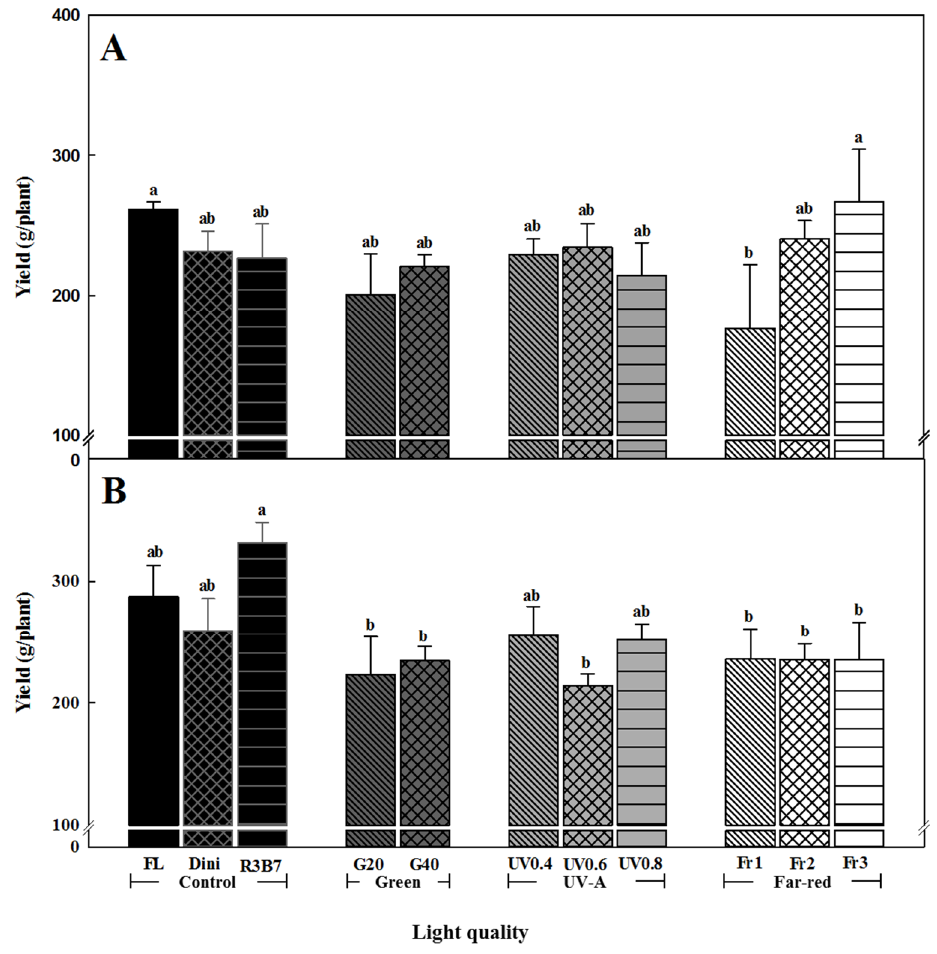
Figure 11. The effects of light quality on yield of first flower cluster ( A ) and yield of second flower cluster ( B ) of ‘Mini Chal’ tomato ( Solanum lycopersicum L.) measured after transplanting. Refer to Figure 1 for details on the light quality. Vertical bars indicate the mean ± SD ( n = 9). Different letters above bars indicate significant differences by Duncan’s multiple range test at p = 0.05.